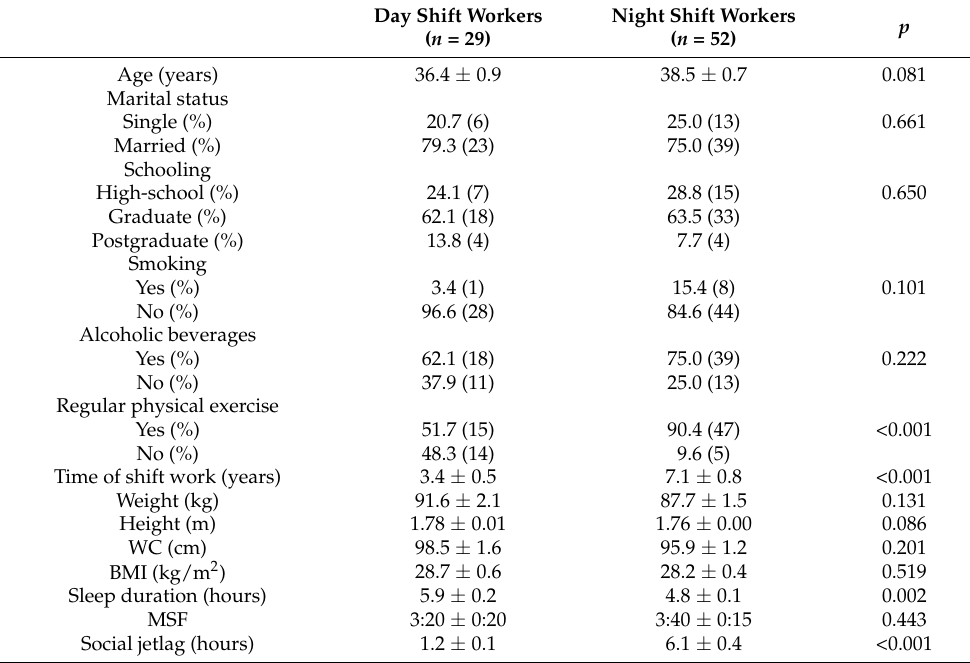
Table 1. Sociodemographic characteristics, lifestyle, anthropometric variables, and sleep variables of participants according to the work shift.